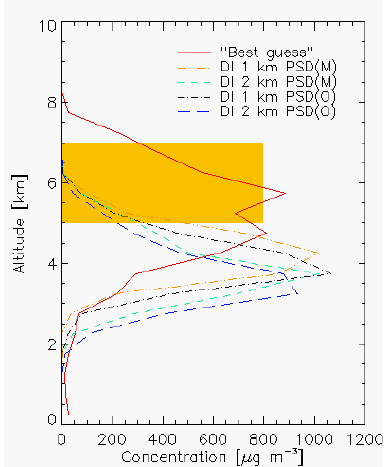
Figure 2: Ash concentration profiles for 1315 UTC 14 May at 59.6°N 7.0°W. The solid line is the “best guess” NAME source term estimate. Other lines are the data insertion (DI) method assuming 1 and 2 km thick ash layers using the measured distal (M) and operational (O) PSDs shown in Table 1. The line “DI 1 km PSD(M)” is from Fig. 1d). The filled box shows the approximate observed concentration profile from Fig. 13c) in Johnson et al.